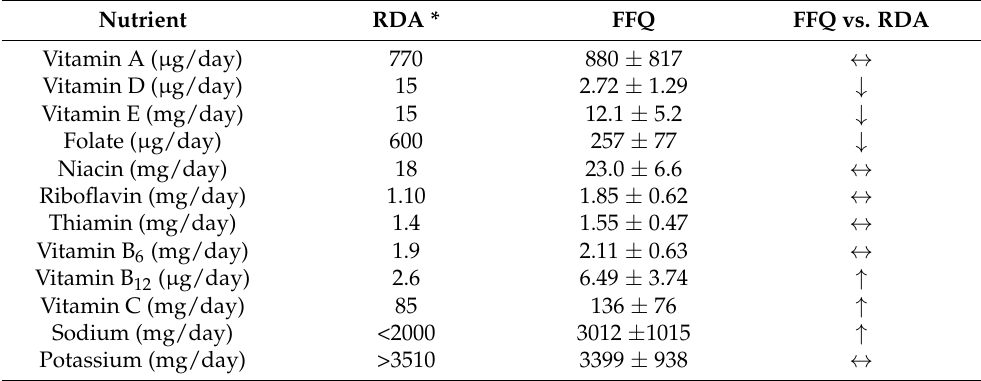
Table 4. Daily micronutrient intake and sodium-to-potassium ratio assessed by EPIC-Norfolk Food Frequency Questionnaire (FFQ) in healthy pregnant